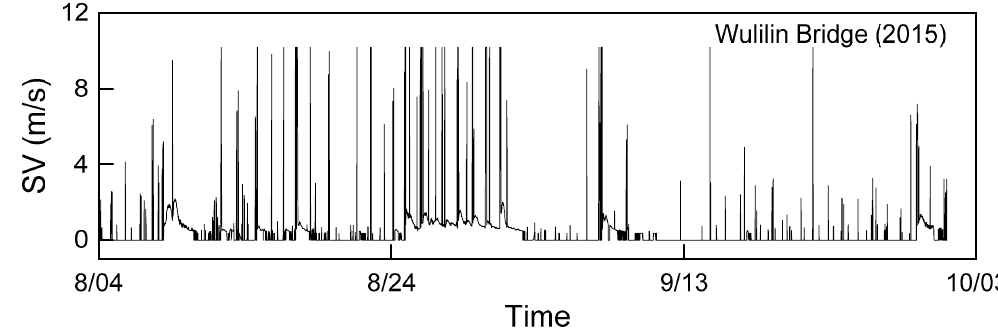
Figure 1. Raw SV data from the Wulilin Bridge station during a rainfall season.